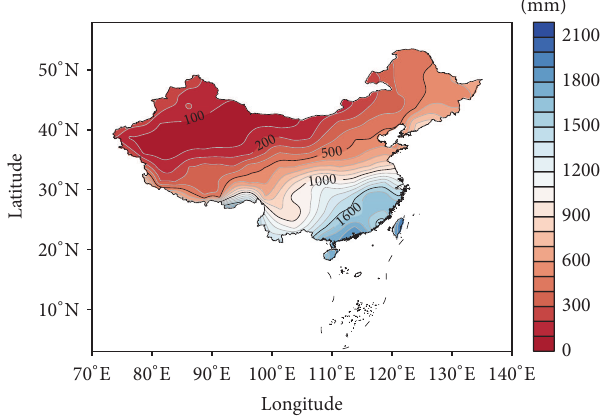
Figure 9: Distribution of annual average precipitation in China from 1979 to